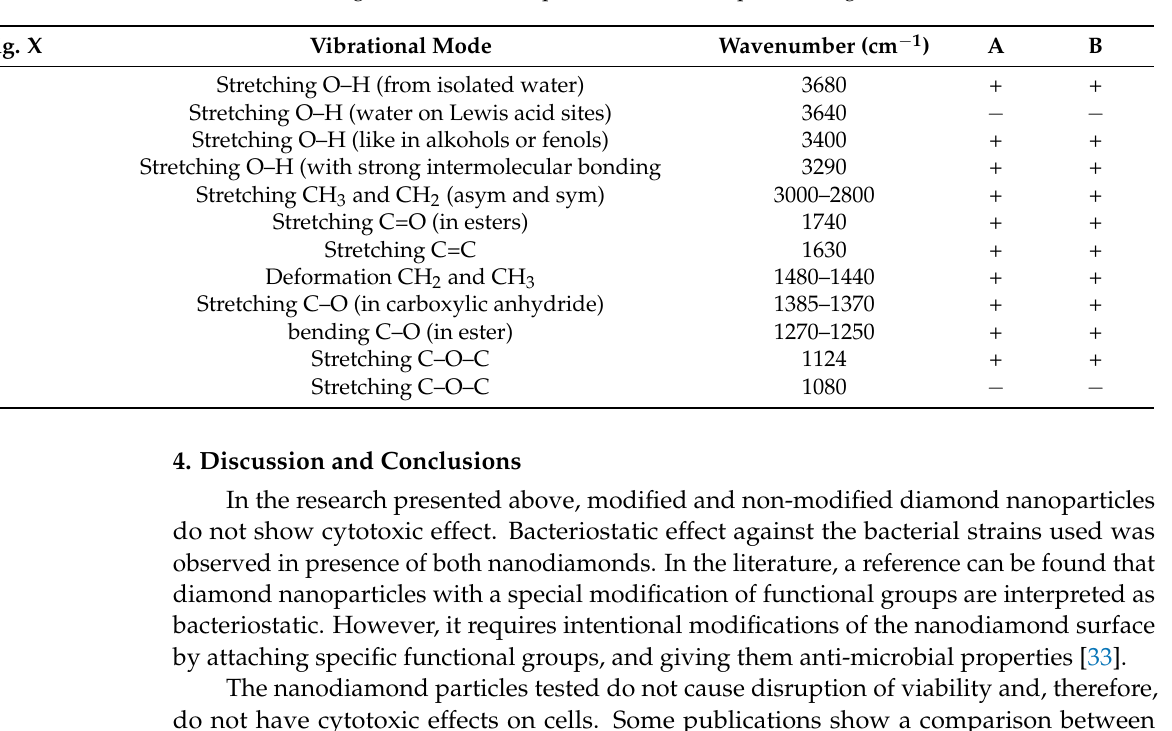
Table 4. Bond assignment of IR absorption bands in the spectral range 4000 cm − 1 to 400 cm − 1